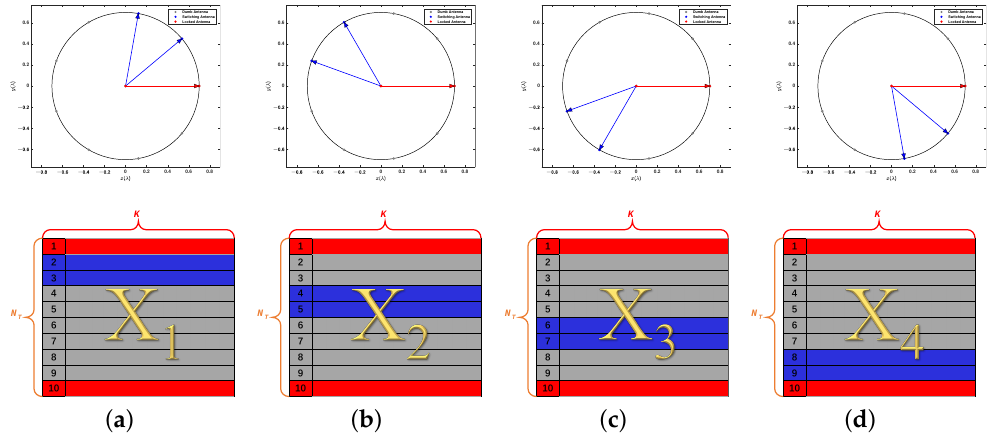
Figure 2. Switching scheme: ( a ) the first switching; ( b ) the second switching; ( c ) the third switching; ( d ) the fourth switching.